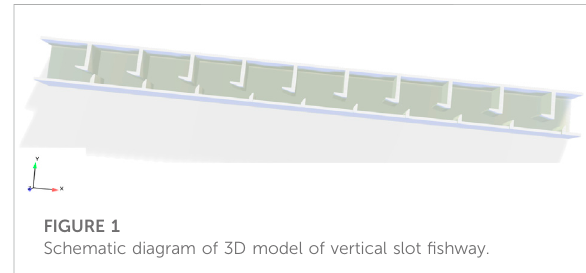
FIGURE 2 Schematic diagram of 3D model of over fl ow weir fi